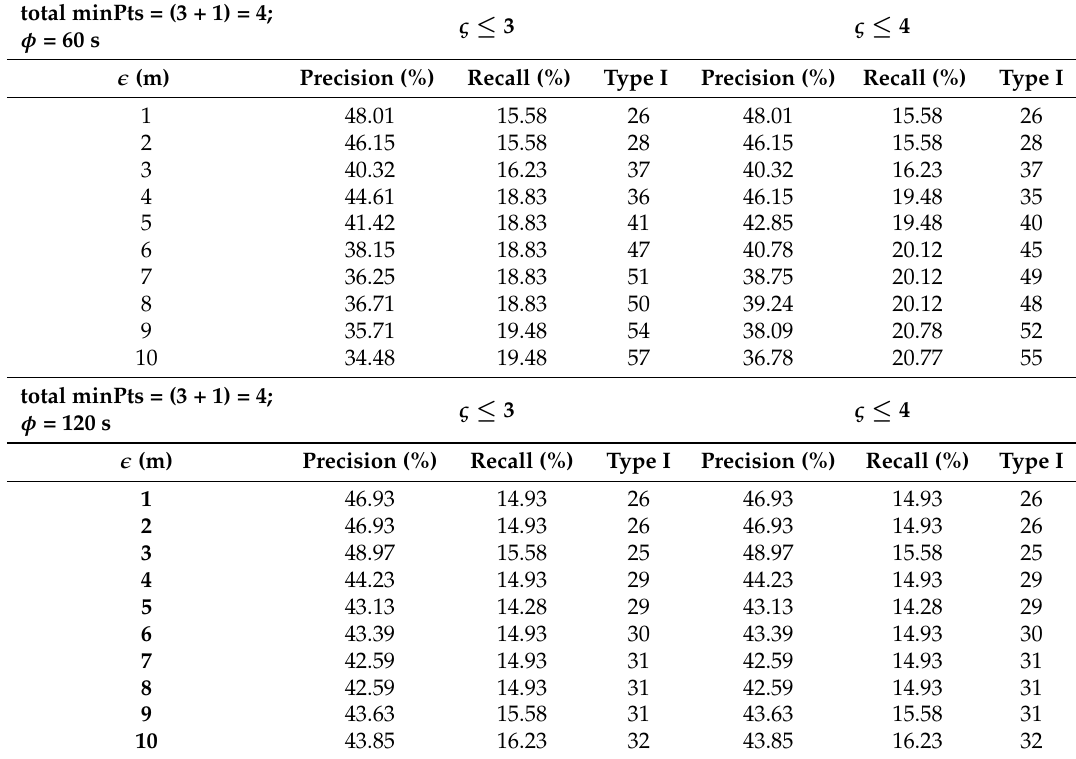
Figure 15. A continuous acceleration profile showing distinct behavior of different transport modes even through the semantic gap due to GPS signal loss on the ( TrajectoryID 150615_1 ) . Table 13. Trip detection accuracy by a geometric clustering-based